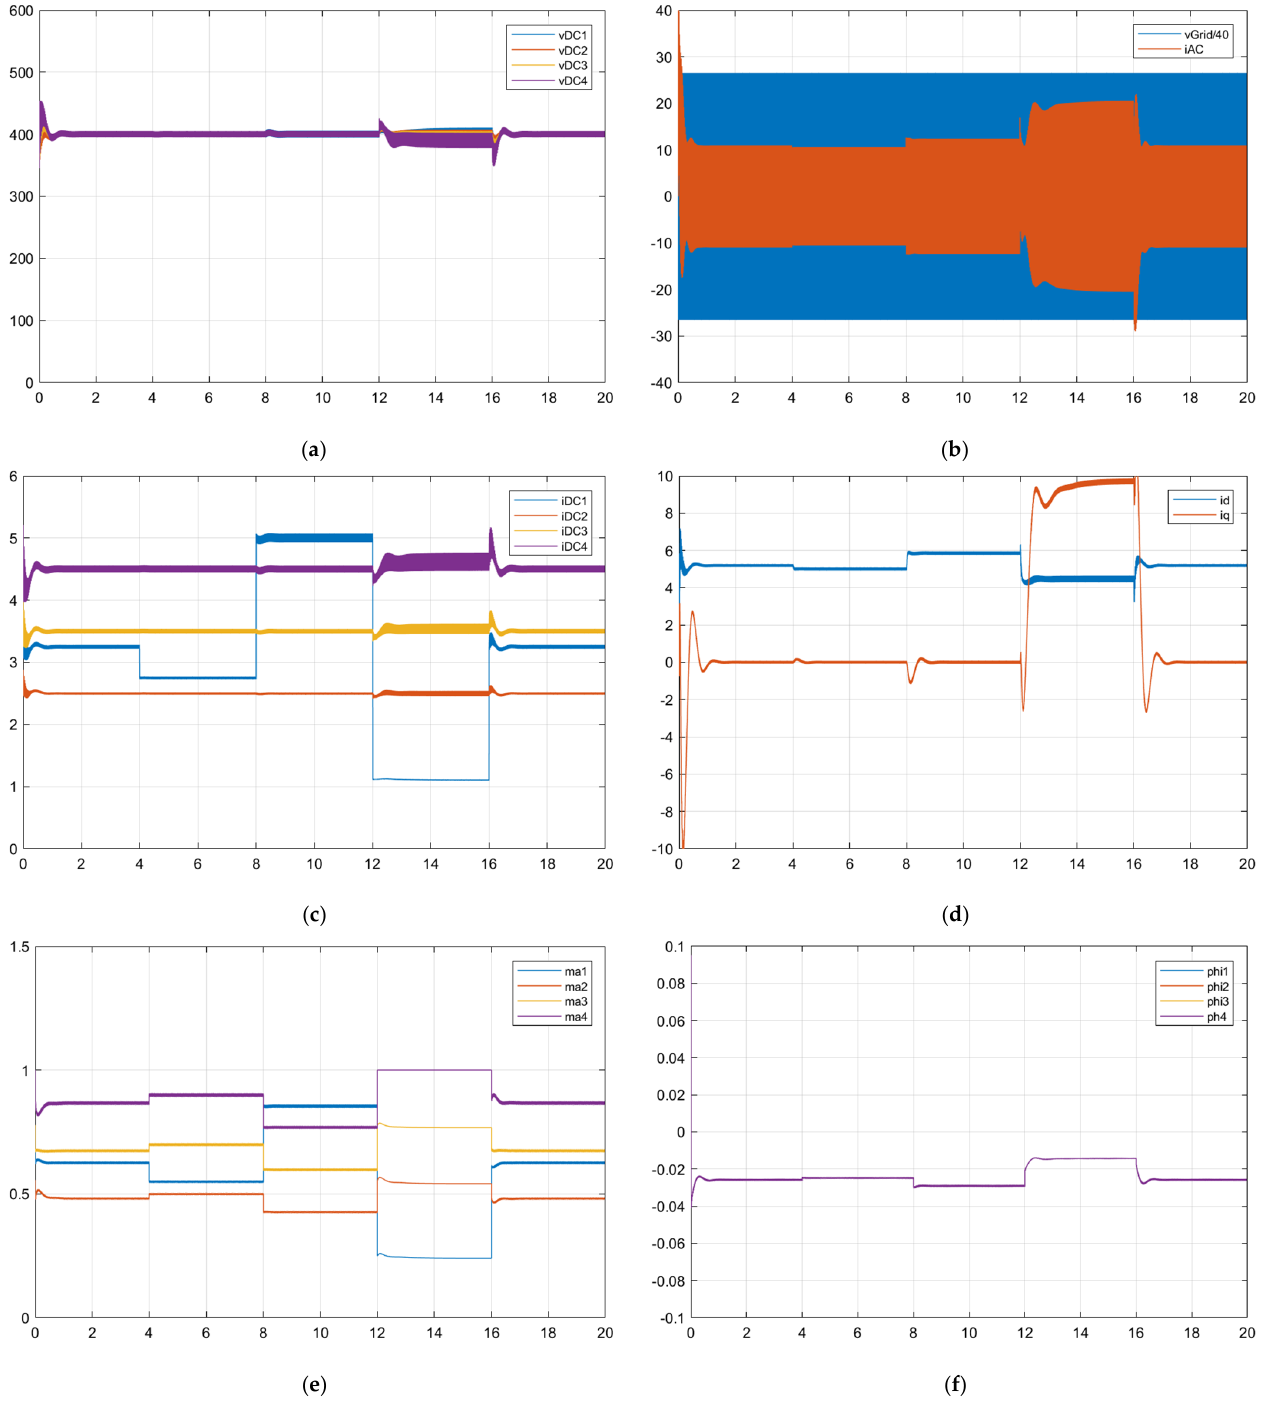
Figure 11. Simulation results when using extended by reactive power operation (ERPO) strategy for case B: ( a ) PEB output DC voltage, ( b ) PEB output DC current, ( c ) grid voltage and current, ( d ) grid d–q current components, ( e ) PEB amplitude modulation index and ( f ) PEB modulation waveform phase.